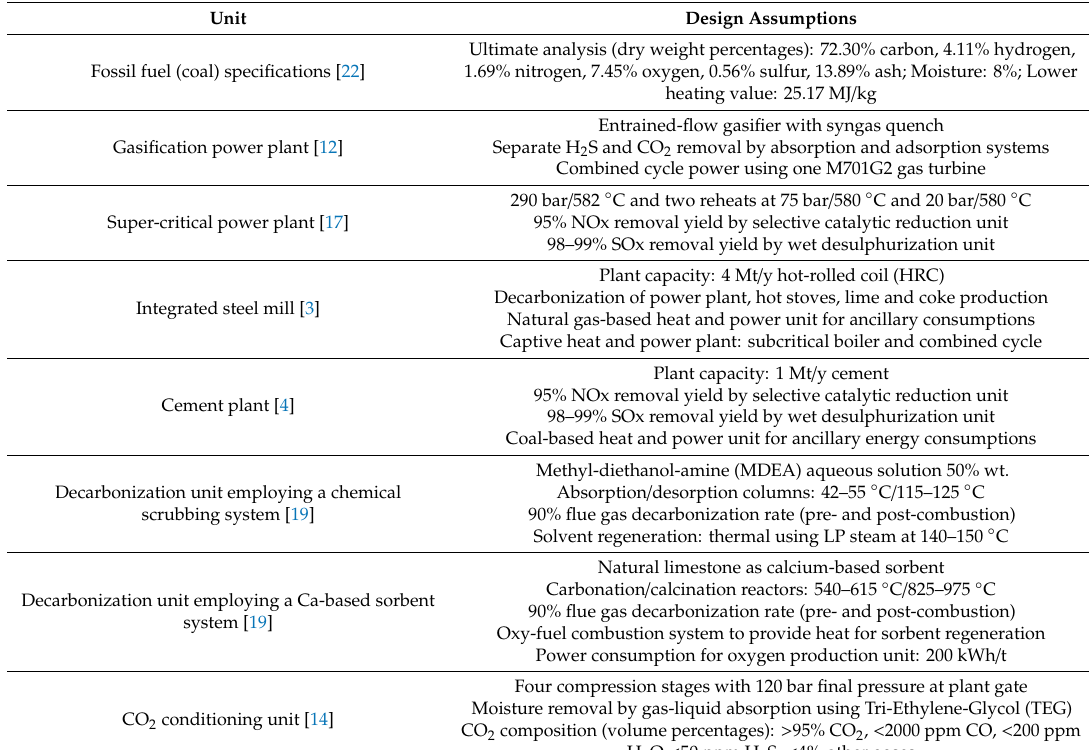
Table 1. Main design elements of evaluated decarbonized industrial processes.